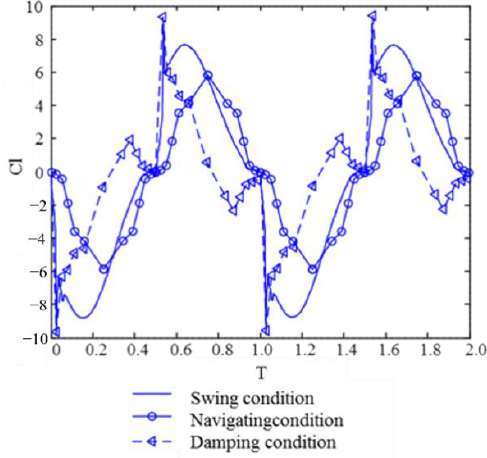
Figure 16. Damping characteristics curves.